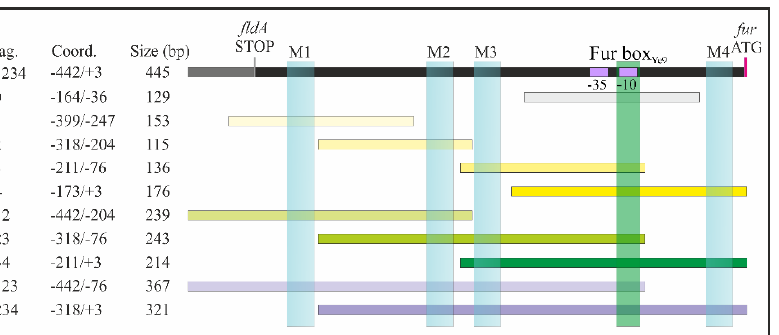
Figure 5. DNA fragments of the Y. enterocolitica Ye9N fur regulatory region used in electrophoretic mobility shift assay (EMSA) experiments. The position of DNA fragments within the extended Y. enterocolitica fur regulatory region is shown. The fragments contain one (yellow bars), two (green bars), three (purple bars) or four (black bar) putative OmpR-binding sites, or no sites (gray bar). Light blue rectangles indicate the location of the four potential OmpR-binding motifs M1, M2, M3 and M4. The putative Fur box Ye9 is marked in green, and the −10 and −35 core promoter motifs are marked in violet. The DNA fragment names, sizes and coordinates relative to the first nucleotide of the fur ATG start codon (marked in pink) are given. All fragments were amplified with primers listed in Supplementary Table S2.